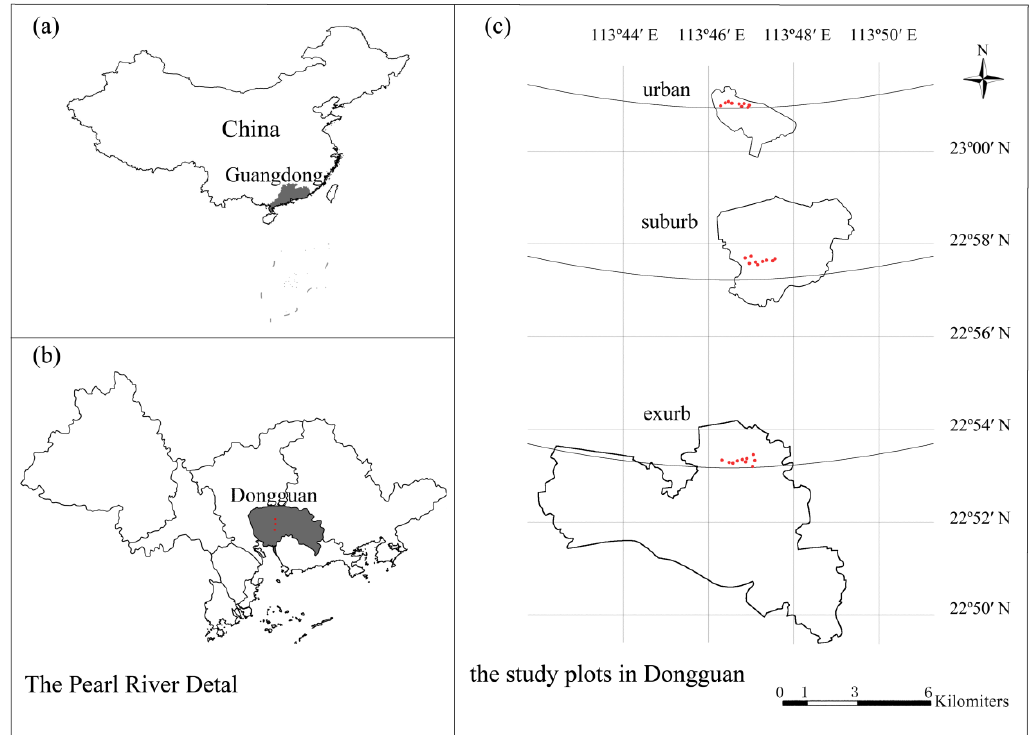
Figure 1. Locations of the three study sites and 27 plots in Dongguan, south China.